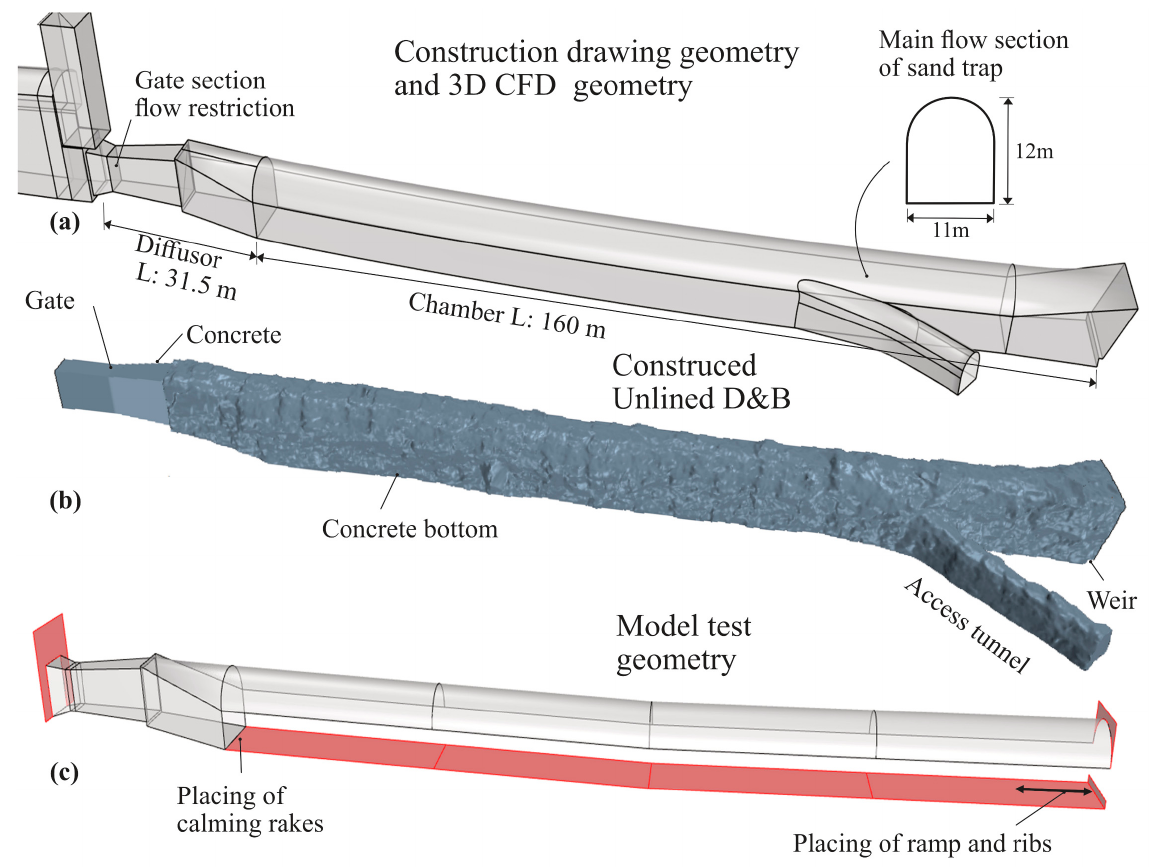
Figure 2. Geometry of the pressurized sand trap no. 3; ( a ) design from construction drawings used in 3D CFD simulations; ( b ) 3D scan of the as-built structure [17]; ( c ) model test geometry placed in the flume, with plastic in the red color and acrylic glass material in the transparent color, the missing sidewalls are the glass walls of the flume with 30 cm internal width. The placement position of two of the tested retrofitting options, calming rakes and ramp and ribs, are indicated.